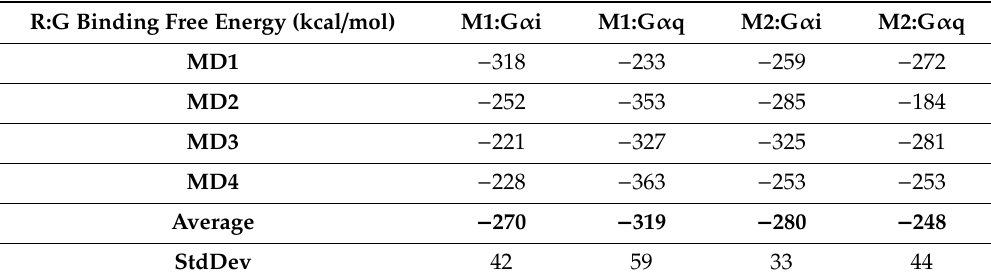
Table 1. The molecular mechanics / Poisson–Boltzmann surface area (MMPBSA)-based free energy of binding of the G α protein to the receptor. Energies are shown for each of the four MD runs for each of the four complexes, along with the average free energy of binding in bold for each complex in kcal / mol. R:G Binding Free Energy (kcal / mol) M1:G α i M1:G α q M2:G α i MD1 −